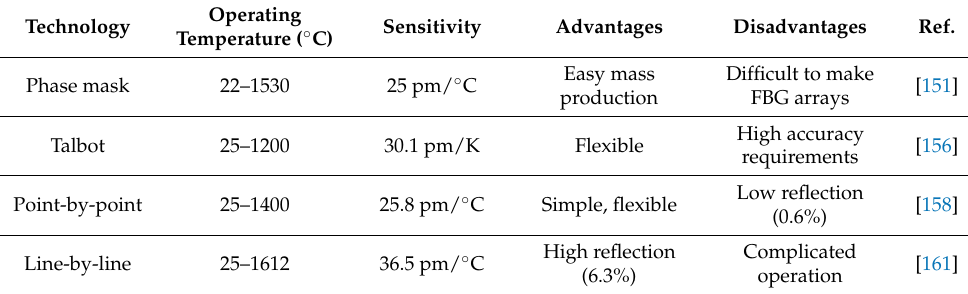
Table 6. Comparison of SFBGs fabrication